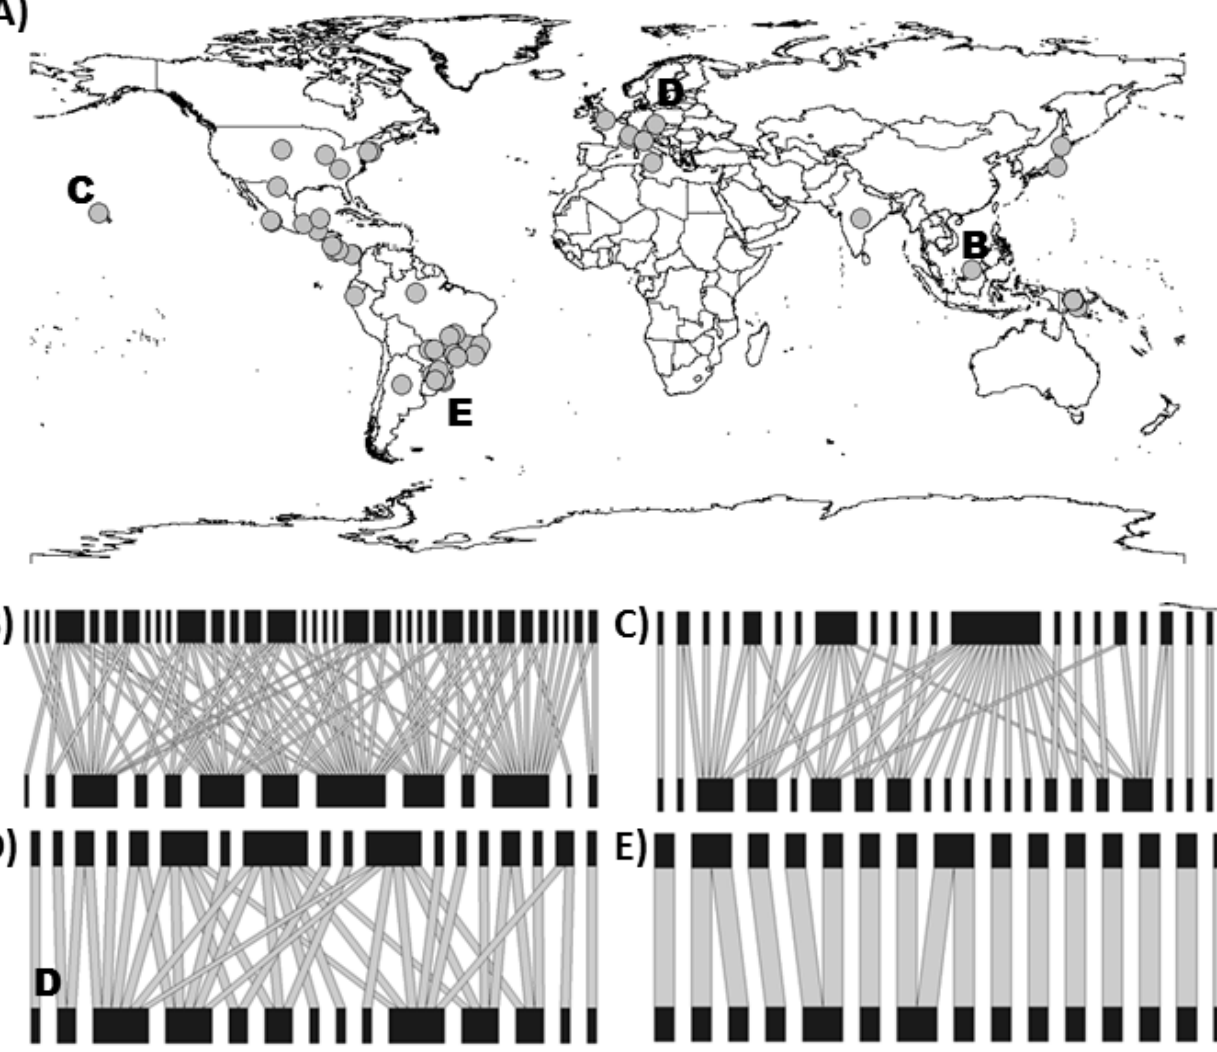
Figure 2. (A) Global distribution of the plant-herbivore networks used in the current study. Some of the networks localities are indistinguishable at this map scale. (B-E) Examples of plant-herbivore networks with different levels of land use intensity (LUI) and specialization. Herbivores are on the top and plants on the bottom of the networks. The networks are arranged in descending order of residual connectance. (B) Network with LUI level 1; (C) Network with LUI level 2; (D) Network with LUI level 3; (E) Network with LUI level 4. Modified of Araújo et al. (2015b). frontiers of biogeography, ISSN 1948-6596 — © 2016 the authors; journal compilation © 2016 The International Biogeography